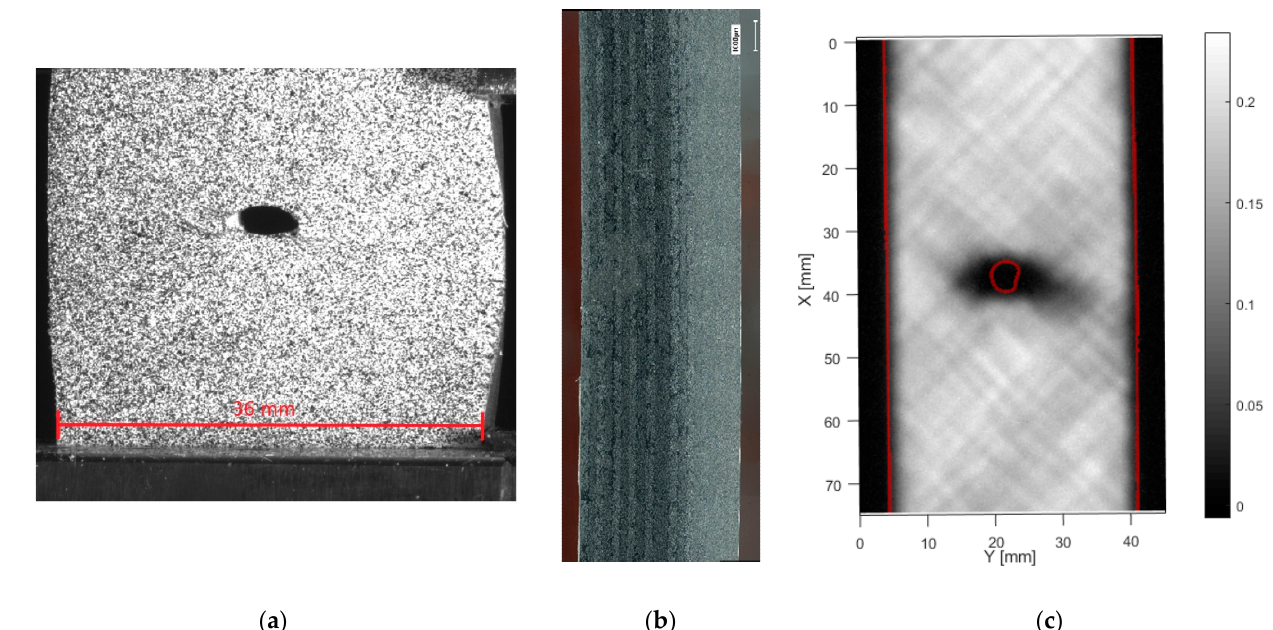
Figure 8. Compressive buckling of specimen with layup [+45/ − 45] 5s , ( a ) front view, ( b ) microscopy of side, ( c ) through transmission ultrasound (for high resolution, please refer to the online version of this article).